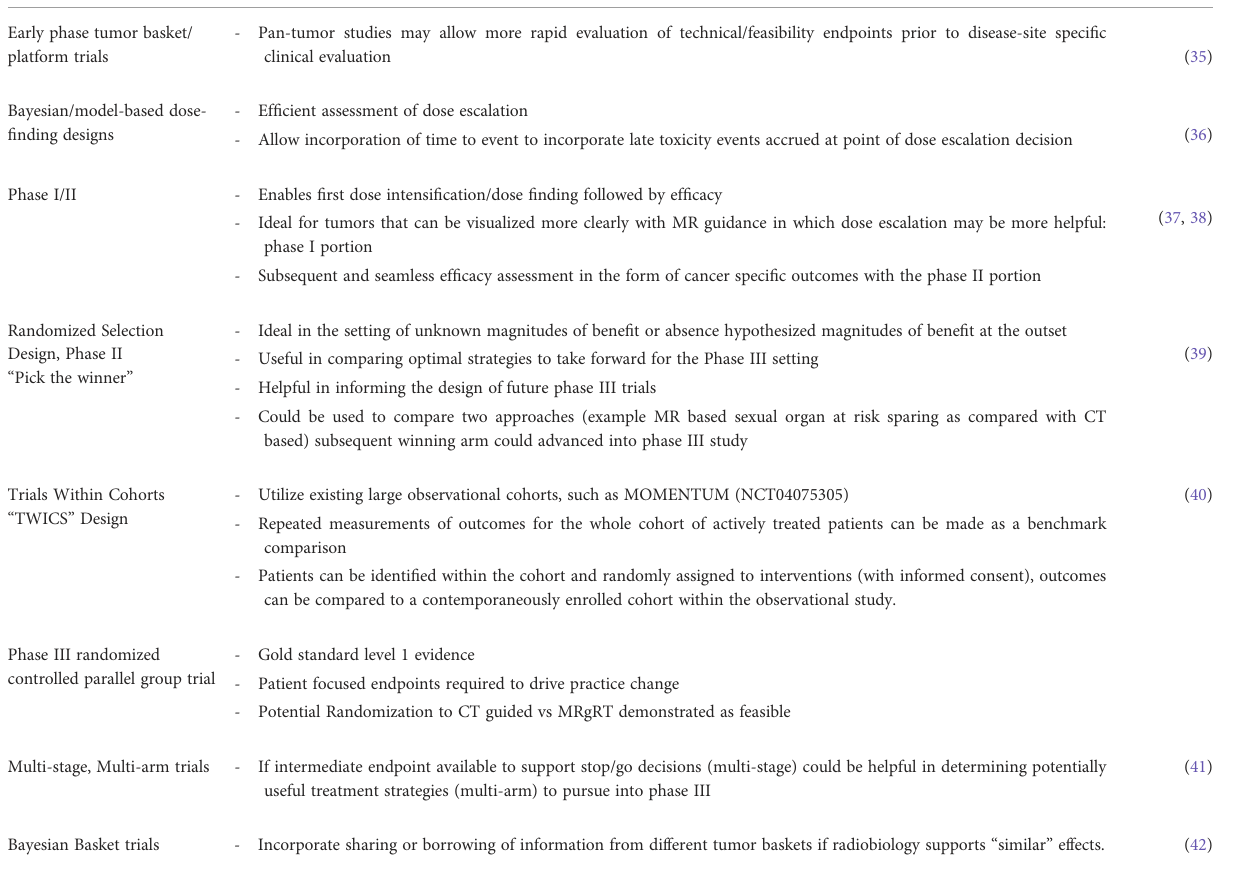
TABLE 3 Potential trial designs for MR guided RT based interventional trials compared with